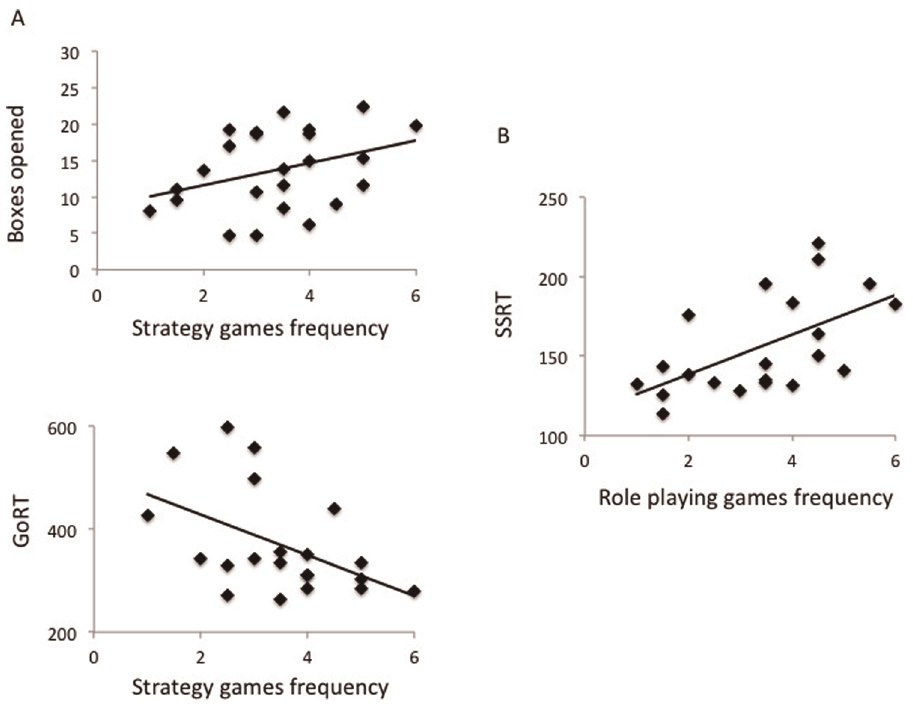
Figure 4. Linear regression of game types with task outcomes. A. Linear regression analysis of the frequency of strategy games played (p=0.02) with Go Reaction Time (GoRT) from the Stop Signal Task and boxes opened from the Information Sampling Task remaining in the model. B. Linear regression analysis of the frequency of role playing games played (p=0.01) with Stop Signal Reaction Time (SSRT) remaining in the model.